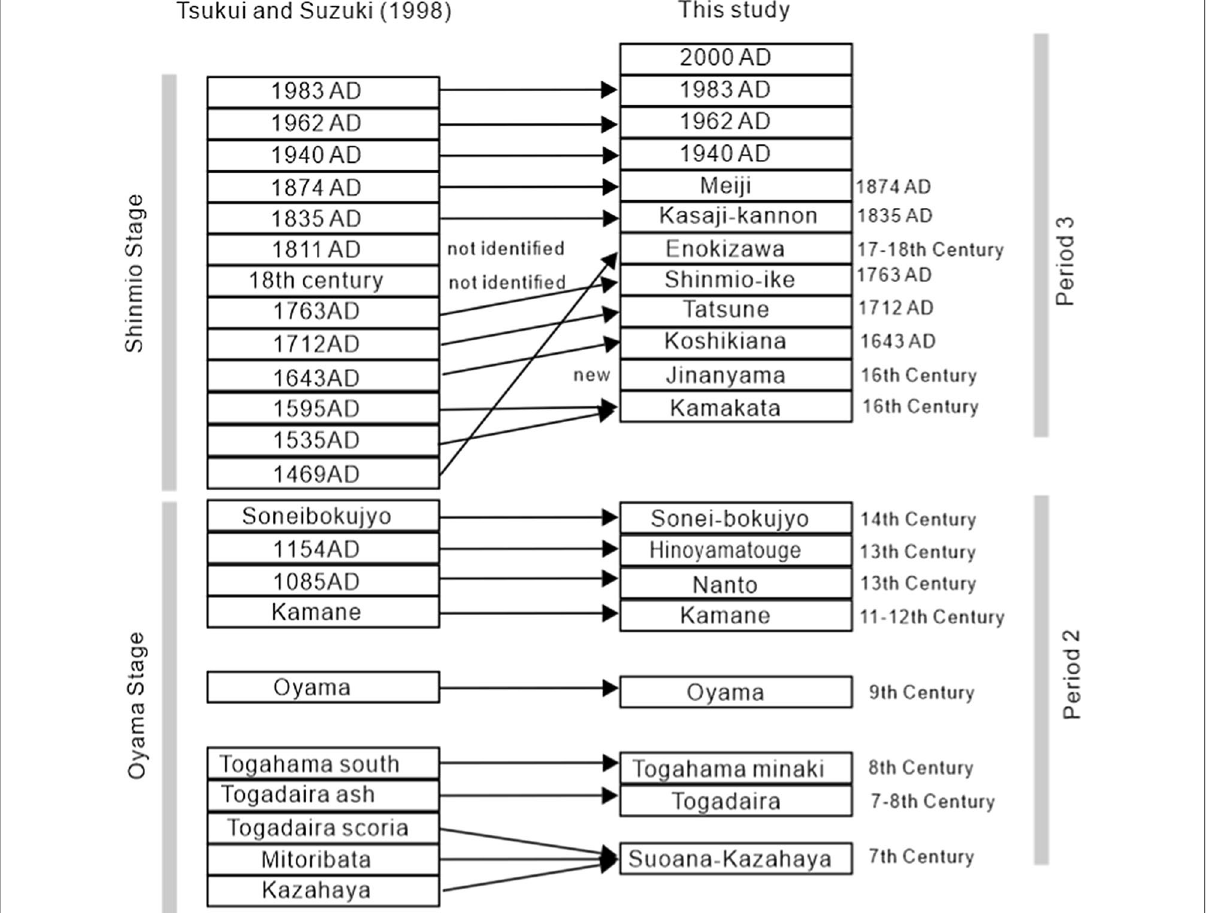
Fig. 12 Correspondence between the eruption units proposed by Tsukui and Suzuki (1998) and those identified in this